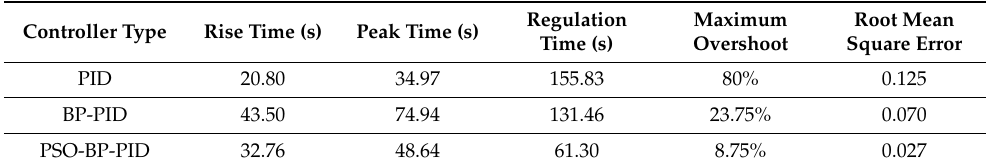
Table 4. Comparison of the dynamic performance of three controllers at fertilizer application flow rate of 0.8 m 3